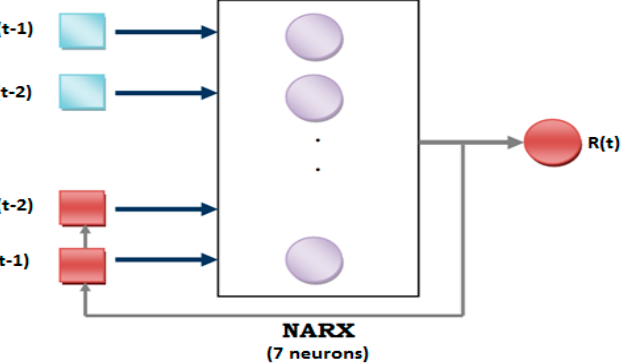
Figure 30. Optimal neural architecture of NARX for the prediction of solar radiation. After the choice of the optimal neural structure, solar radiation is predicted using the NARX model. Simulation results are presented in Figure 31. The blue and red curves cor- respond respectively to the real solar radiation and the predicted one. An approximation between these two curves is observed, they overlap especially when solar radiation fluc- tuations are not important. Compared to the ARMA model, an improvement of solar ra- diation prediction is mainly shown for the high fluctuations.